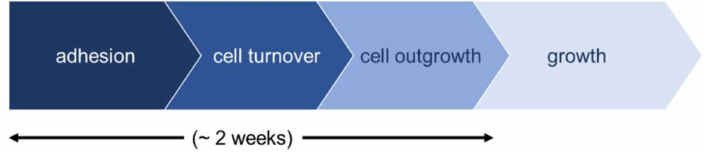
Figure 8. Phases in the process of periosteal sheet